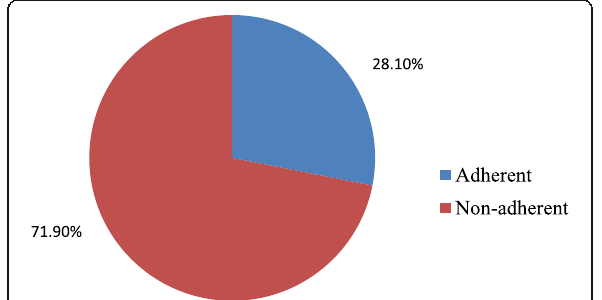
Fig. 1 Adherence to COVID-19 preventive measures among male students of Al-Azhar Faculty of Medicine